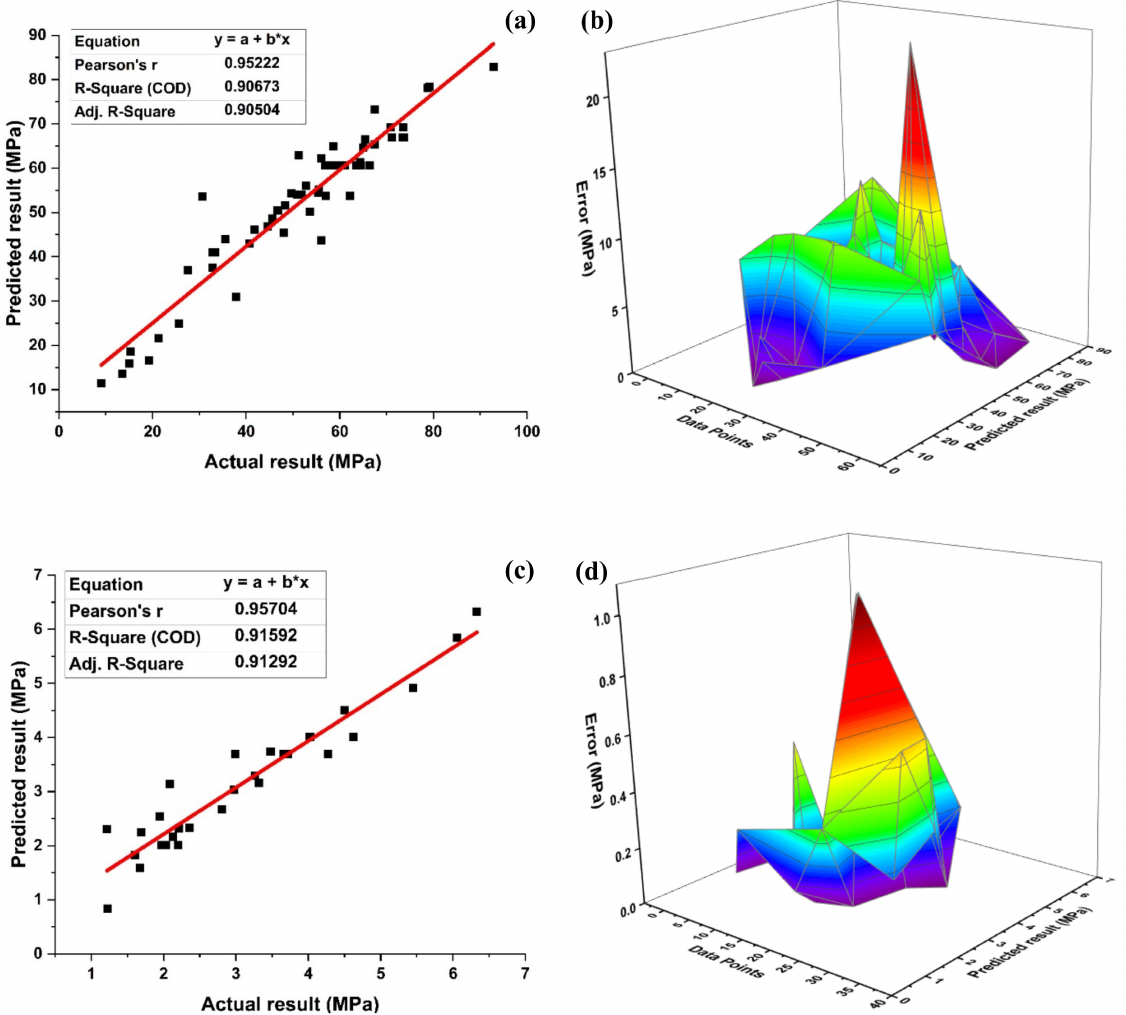
Figure 9. ANFIS model for ( a ) compressive strength and ( b ) its error distribution between actual and target values; ( c ) split tensile strength model and ( d ) its error distribution between actual and target